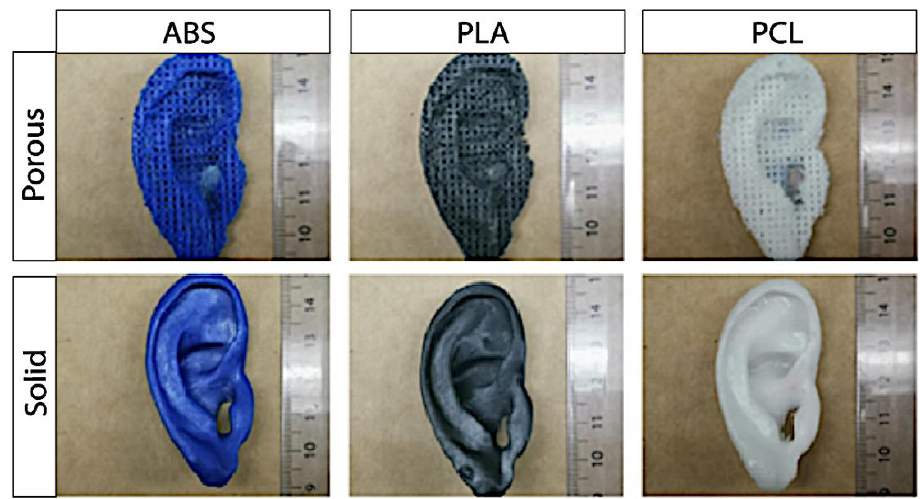
Figure 5. Exemplary pictures of the self-made porous (top row) and solid auricular (bottom row) constructs. Table 3. Statistics for measurements for the dimensions of the porous auricular constructs in mm ( n = 5; the significance threshold was set as * p < 0.05, p -value for all statistical test were ns (= not signif- icant)).